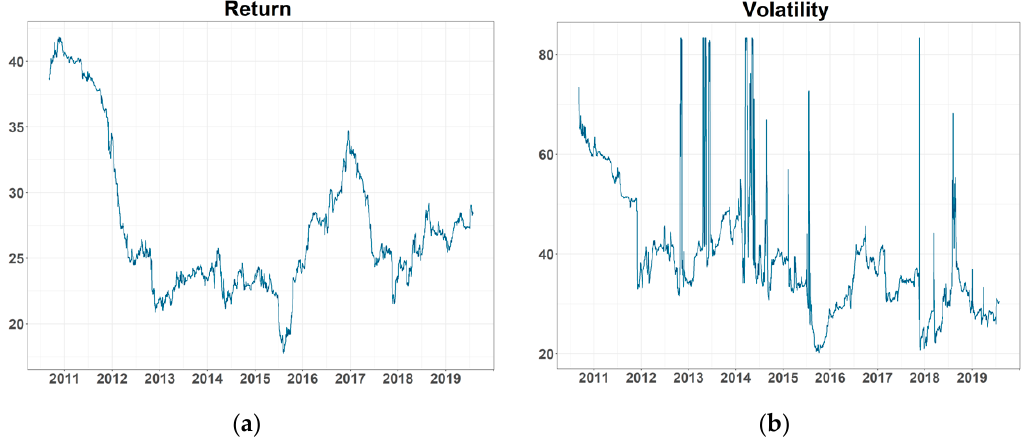
Figure A2. Dynamic connectedness: ( a ) total connectedness of return series and ( b ) total connectedness of volatilities. Note: BRL, RUB, INR, CNH, and ZAR are Brazilian Real, Russian Ruble, Indian Rupee, offshore Chinese Yuan, and South African Rand, respectively. GASF is the Henry Hub natural gas futures price.